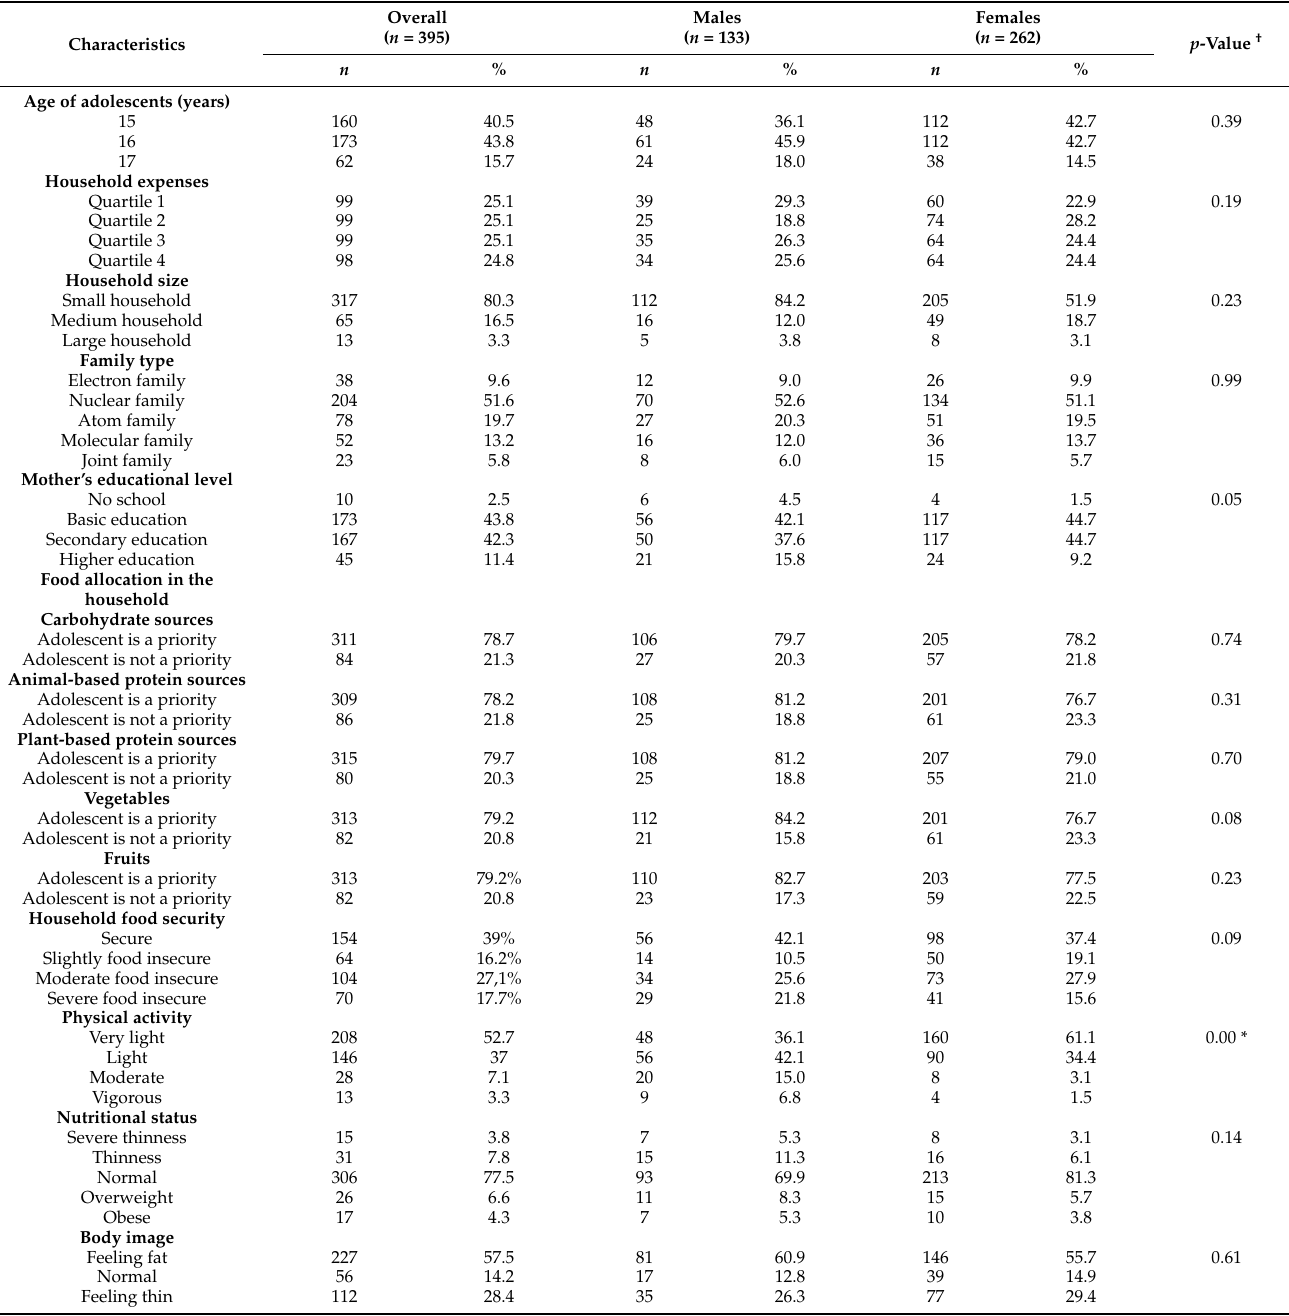
Table 1. Sociodemographic characteristics of